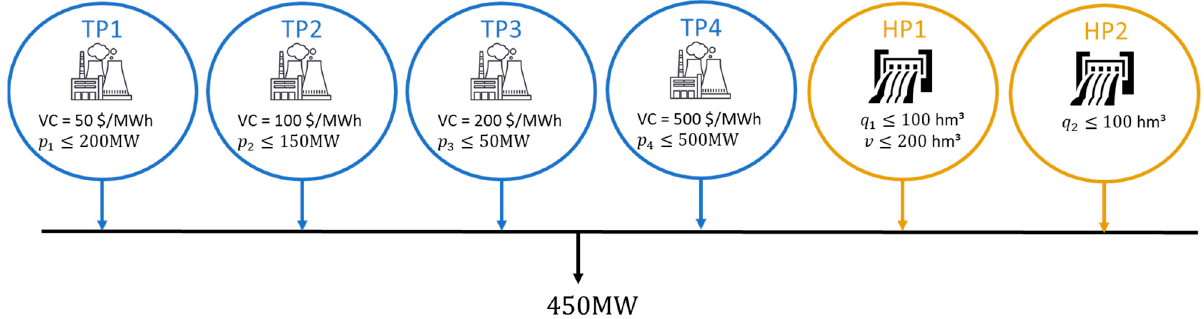
Figure 1. Test system diagram, wherein p i is the power generation of TP i , and VC is the associated operating variable cost. Regarding the hydro resources, q h is the turbined volume of the HP h , and v is the storage volume of the HP1.